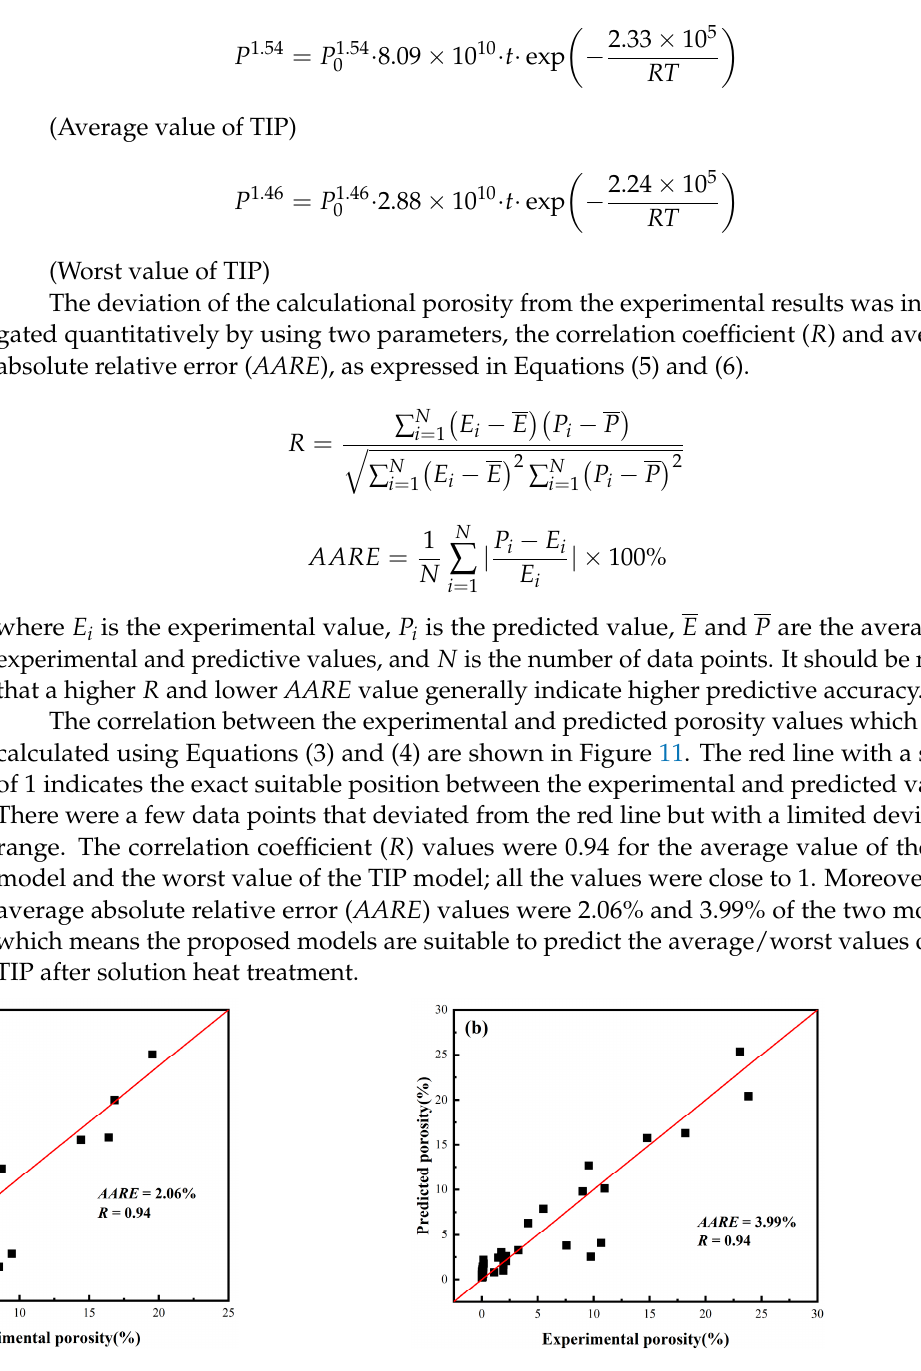
Figure 11. Correlation between the experimental and predicted values of porosity growth models; ( a ) the average value of the TIP and ( b ) the worst value of the TIP.